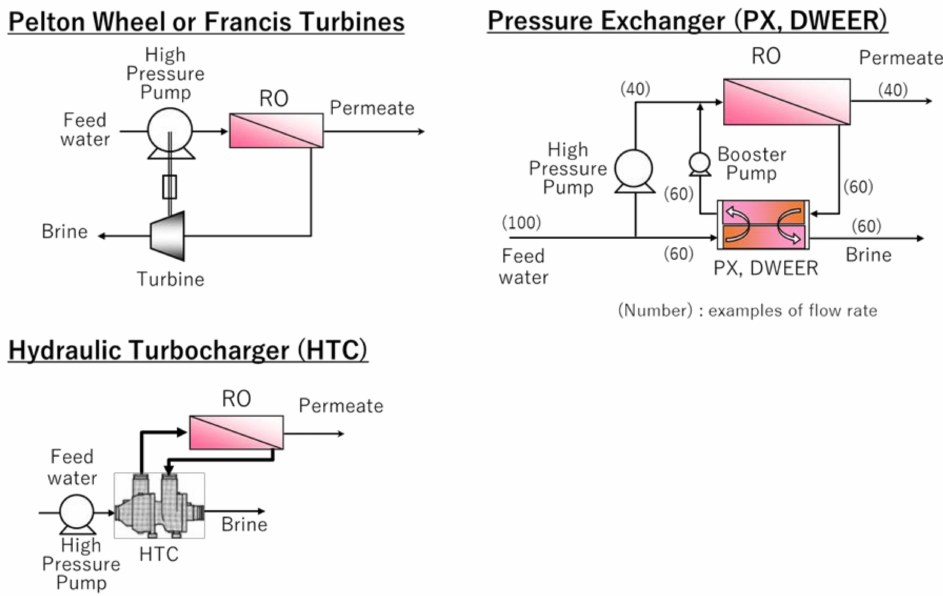
Figure 4. The schematic flow of the typical ERDs (Pelton wheel, Francis Turbines, Hydraulic turbocharger and Pressure exchanger (PX and